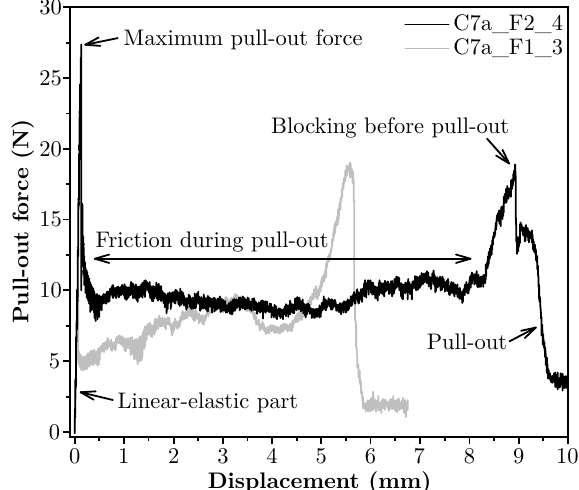
Figure 5. Load-displacement plots of steel fibres type 1 and 2 embedded in mortar